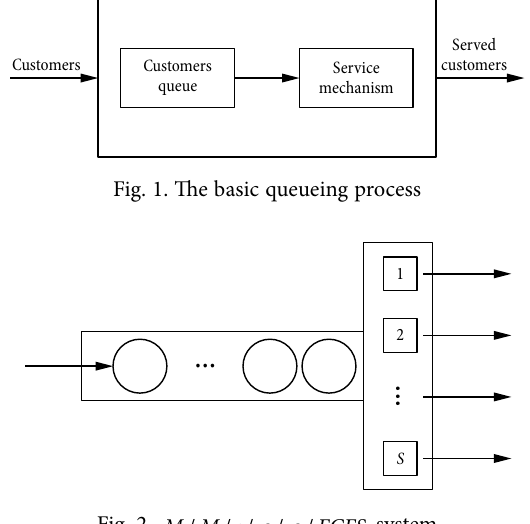
Fig. 1. The basic queueing process